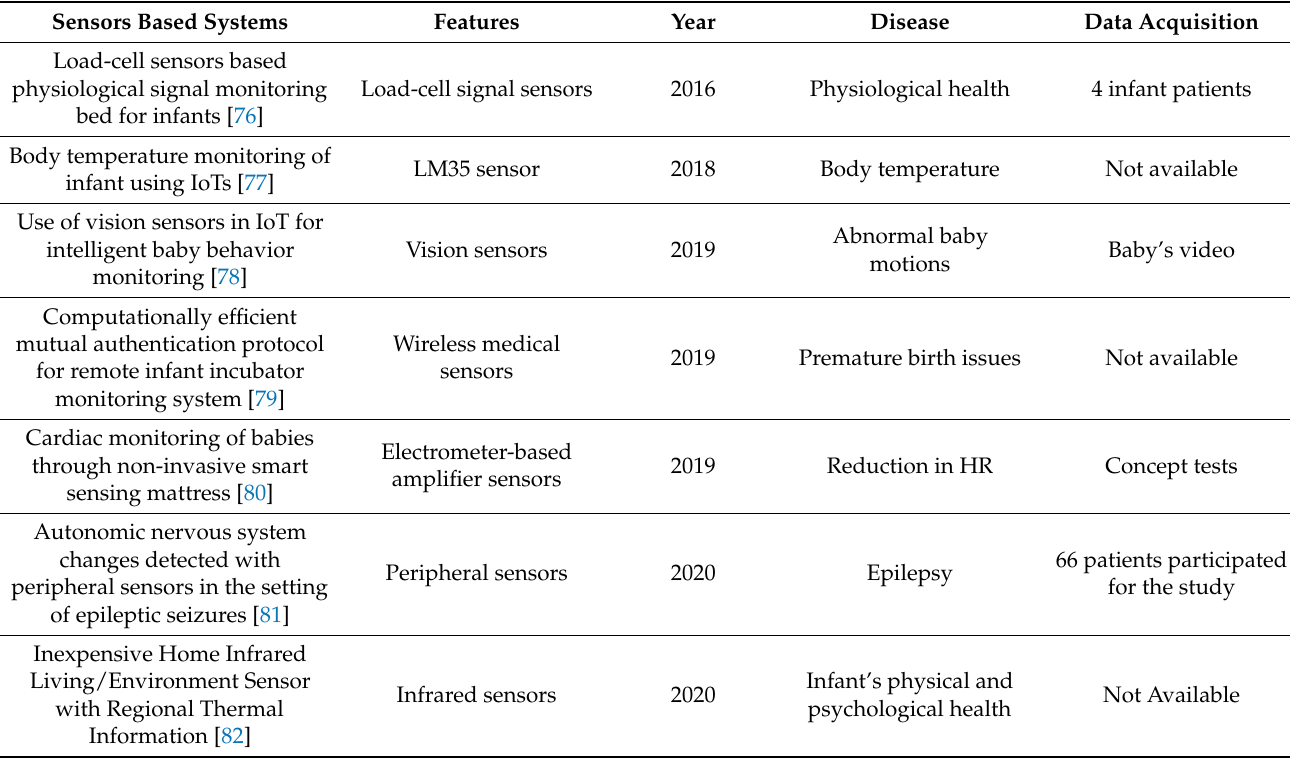
Table 4. Sensors used in infant healthcare